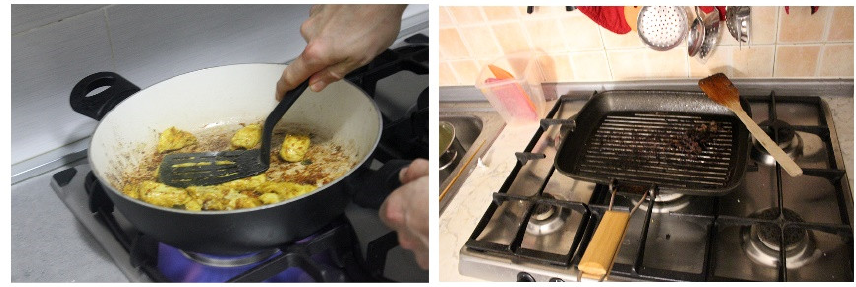
Figure 7. Burning